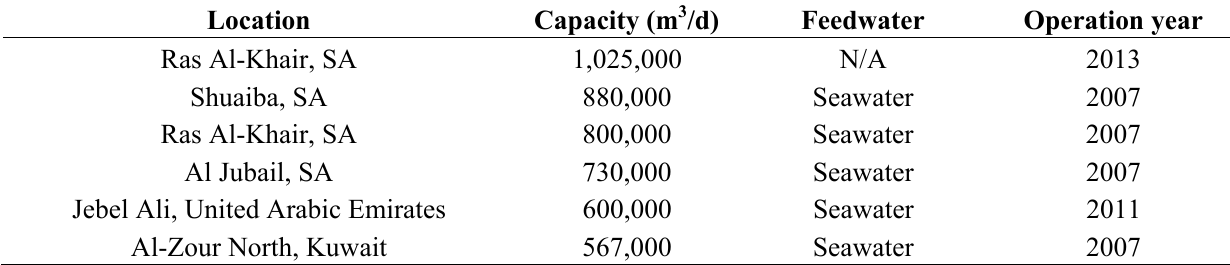
Table 1. The biggest desalination plants around the world. SA: Saudi Arabia; and UAE: United Arab Emirates. Adapted from [12,13,15].